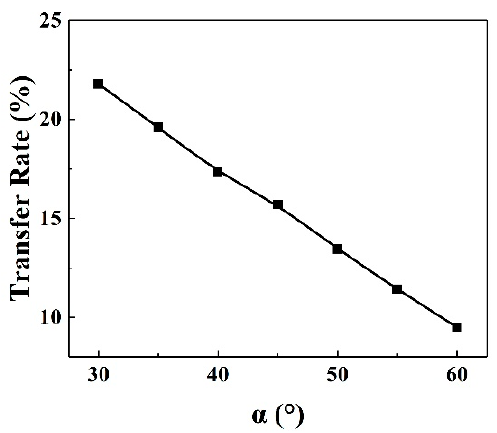
Figure 6. Change of liquid transfer rate with contact angle of upper plate.